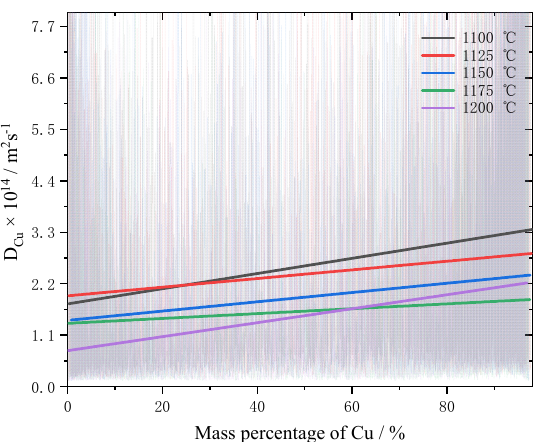
Figure 8. Diffusion coefficient Cu in low carbon steel at different casting temperatures. Since the amount of data tested by the glow discharge instrument is extremely large, and there are also some fluctuations of the data at some positions, the diffusion coefficient values calculated also have certain fluctuations. However, the calculation results could still reflect the Cu diffusion coefficient changing trend with its mass concentration at dif ‐ ferent casting temperatures, and the results are mainly concentrated in the range of 4.0 × 10 − 15 –8.0 × 10 − 14 m 2 /s.